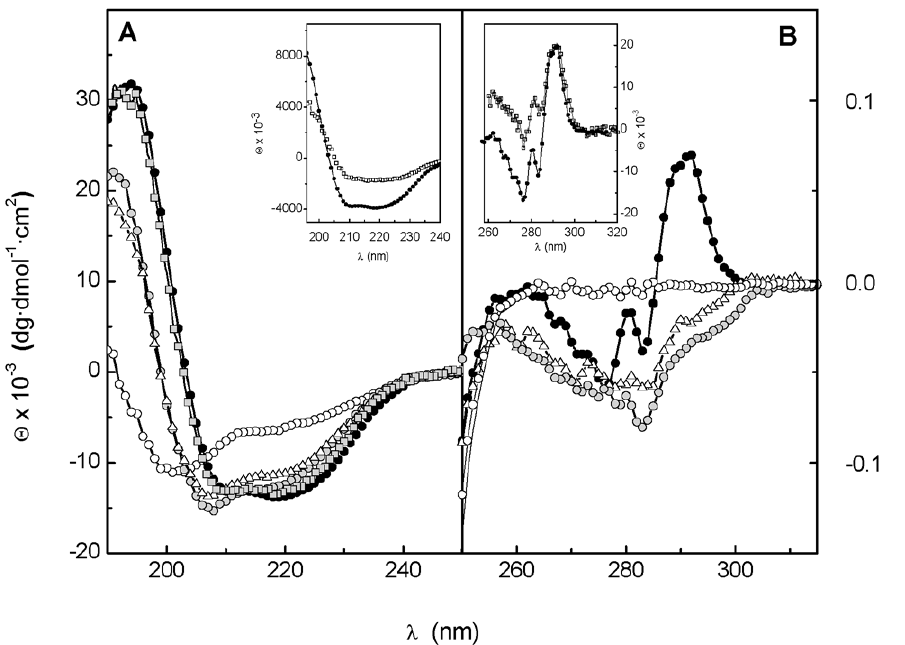
conditions (20 u C) with protein samples heated up to 90 u C (grey circles) and 55 u C (grey squares) are also depicted. The insets compare the spectra of CPL-7 (black circles) and the isolated CM (white squares) with the ellipticities expressed per mole of molecule.